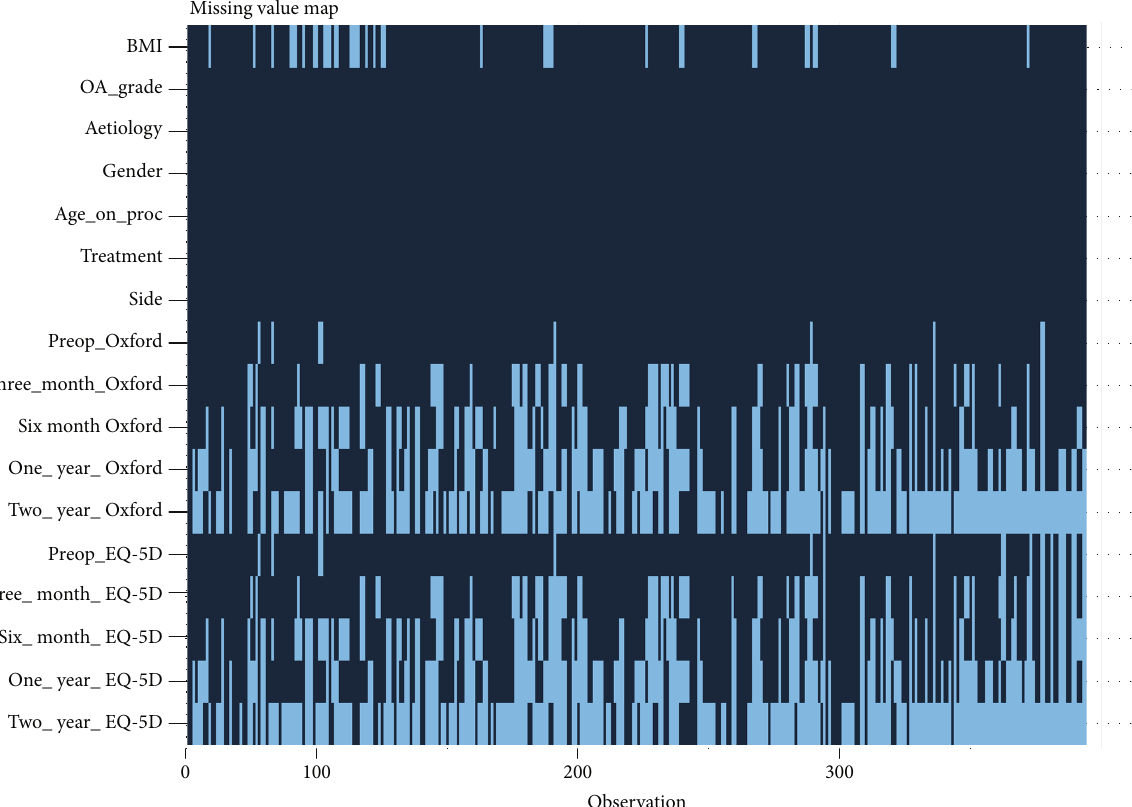
Figure 1: Missingness map of the data x -axis: outcome variables: Kellgren-Lawrence KOA grade (OA grade), aetiology of KOA, gender, age at the time of the procedure, body mass index (BMI), Oxford Knee Score (OKS) for function, and EQ-5D for quality of life at preoperative baseline and three- and six-month and one- and two-year follow-up. y -axis: data points missing (21%) due to patients lost to follow-up